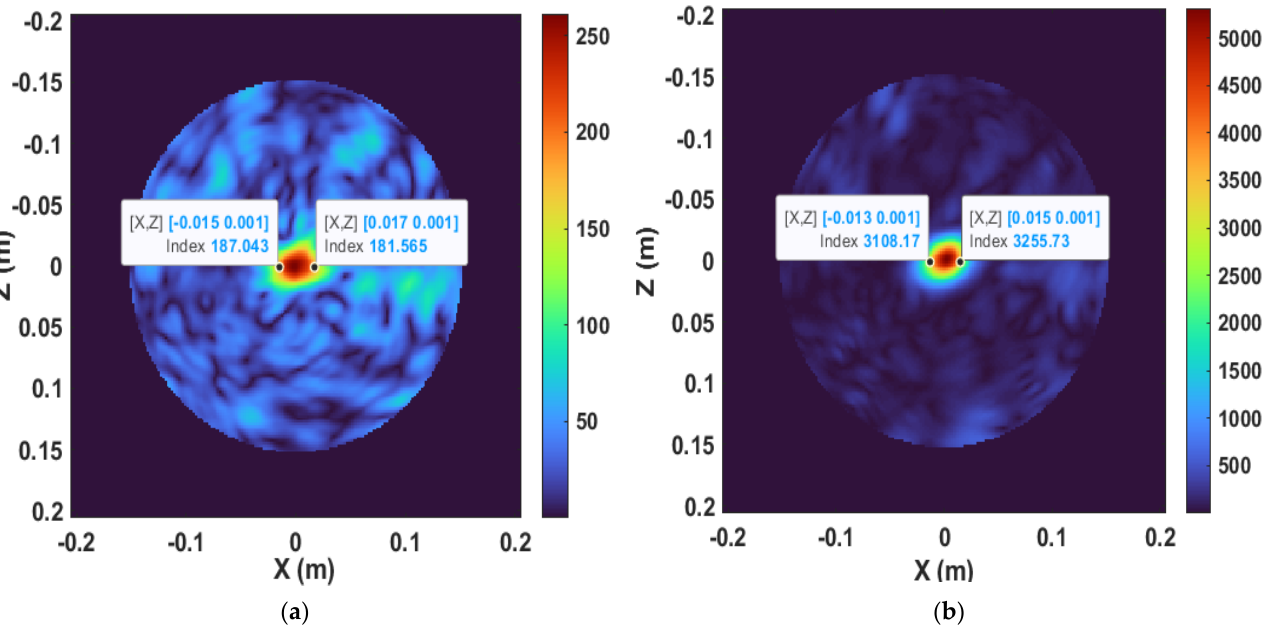
Figure 11. Imaging results of lung phantom with deep-seated 15 mm radius tumor using two beamformers: ( a ) DAS and ( b ) DMAS.